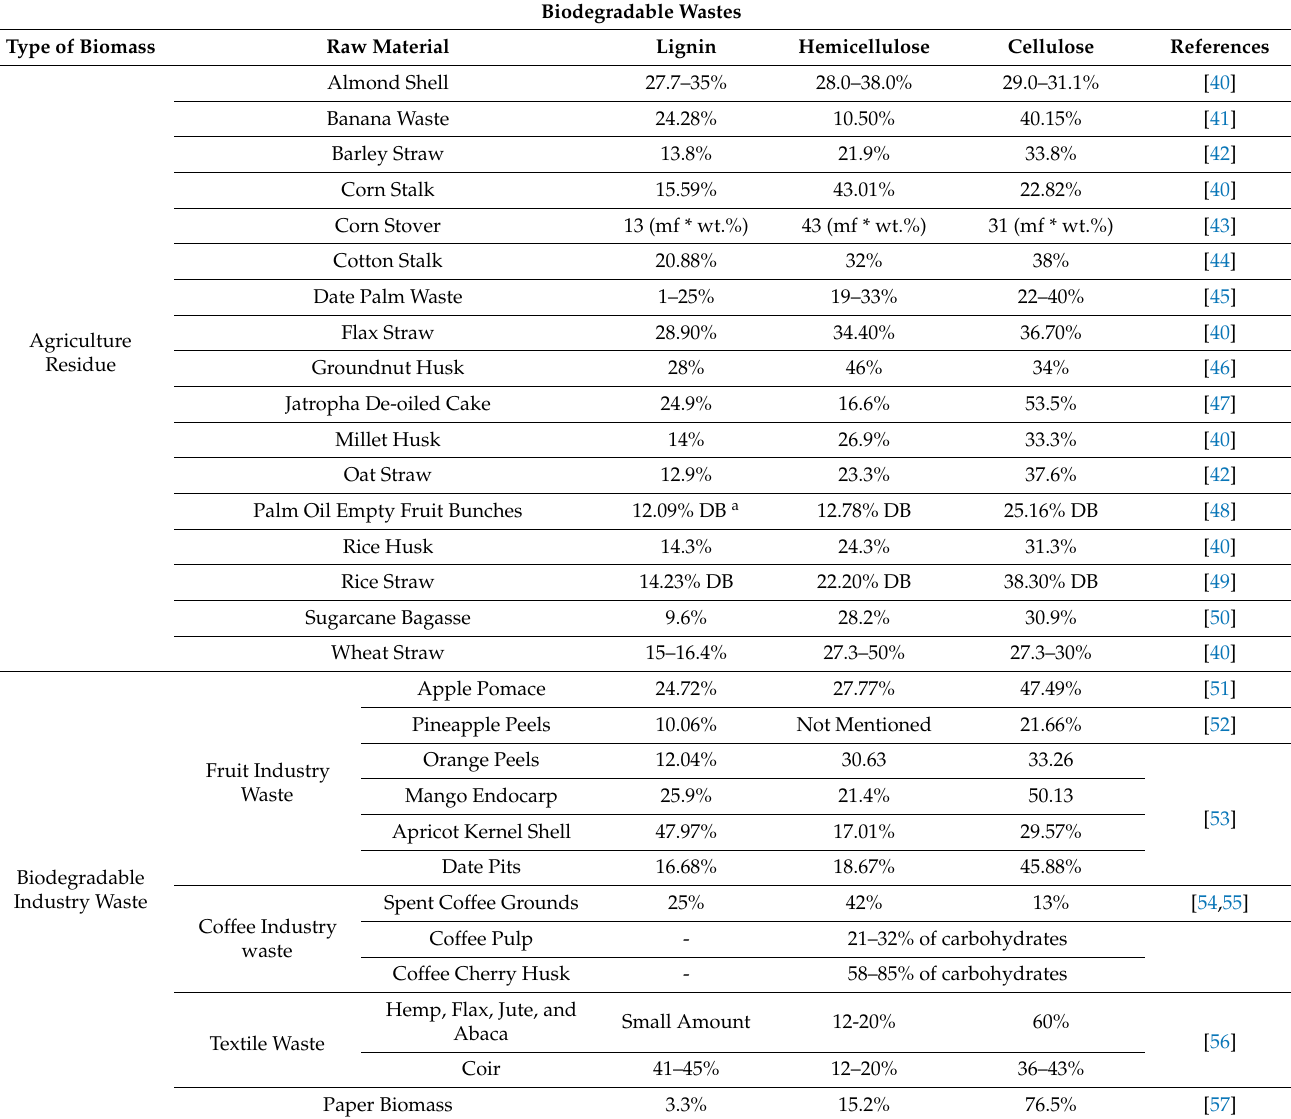
Table 1. Composition of different biomasses used for